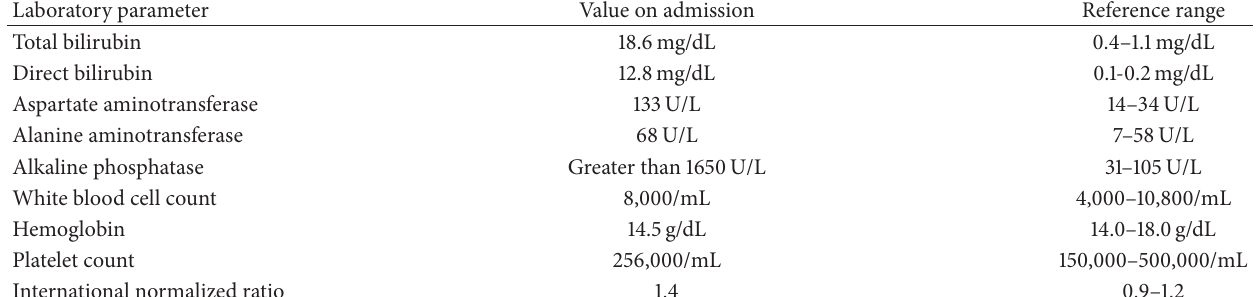
Table 1: Pertinent laboratory values on admission.